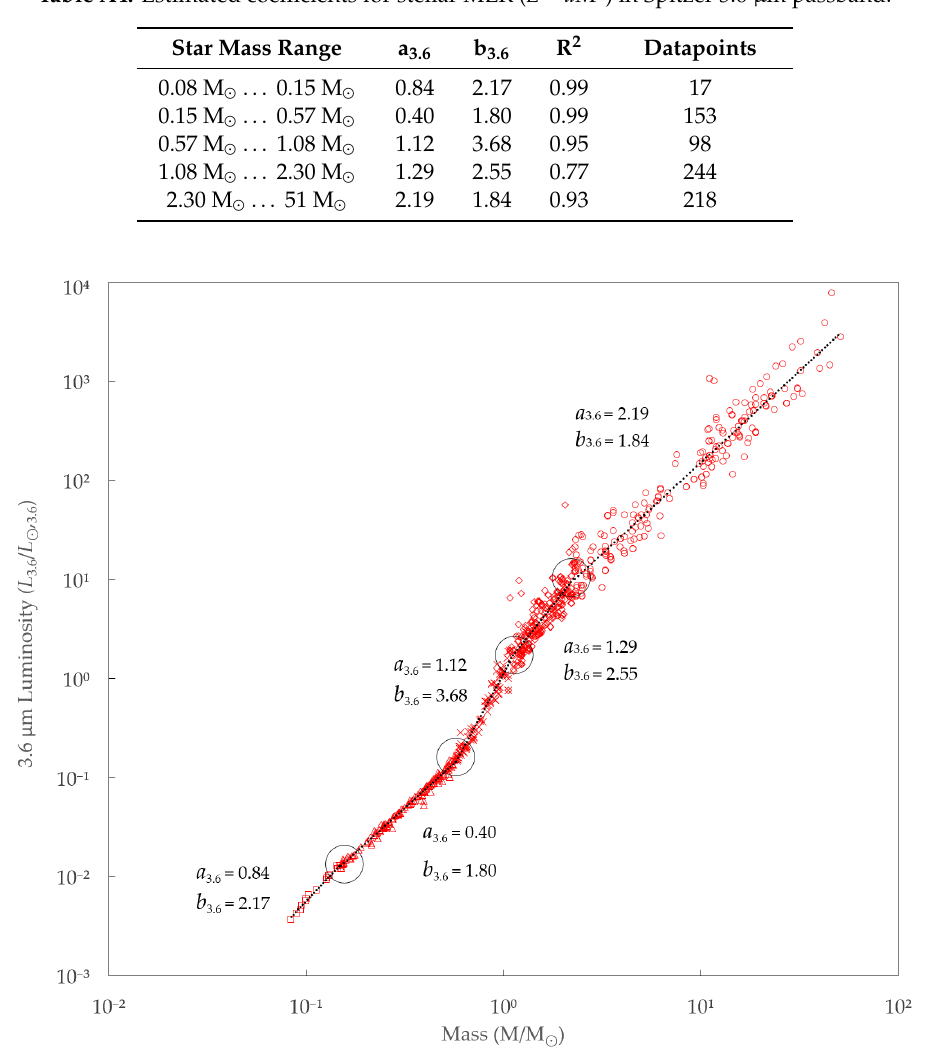
Table A4. Estimated coe ffi cients for stellar MLR ( L = a M b ) in Spitzer 3.6 µ m passband.